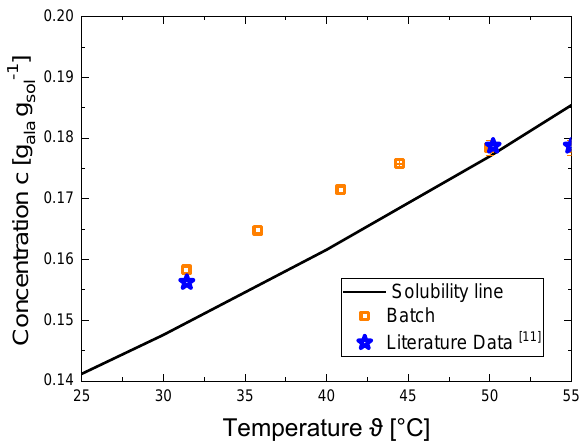
Figure 4. Solution concentrations of batch experiments (orange squares) compared to solution concentrations of continuous SFC operation from literature [11] (blue stars) with constant operating parameters: ϑ ∗ = 50 ◦ C, 1% g solid g solution − 1 recrystallized seed crystals, κ = 1.8 K min − 1 . A relative yield Y rel,batch of 70.2 ± 1.0% was achieved. Compared to the literature data